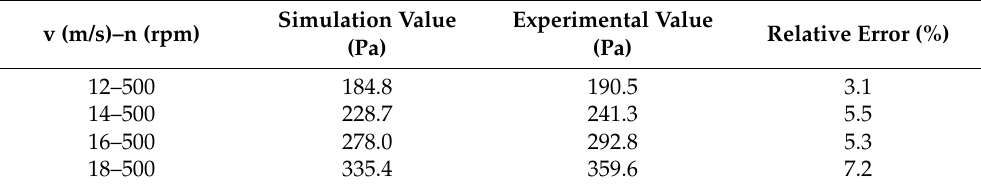
Table 4. Comparison of the pressure drop between the experiment and simulation.